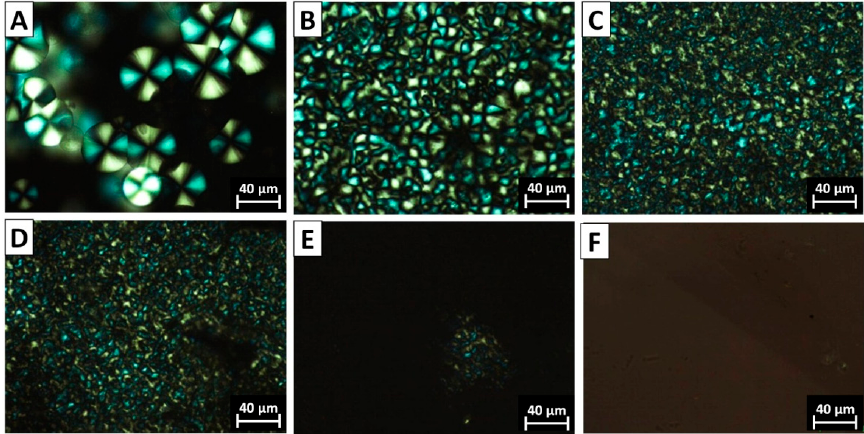
Figure 4. Polarized optical micrograph (POM) images for the PVDF@PMMA samples with the core–shell weight ratio of: ( A ) neat PVDF; ( B ) 90/10; ( C ) 80/20; ( D ) 70/30; ( E ) 60/40; and ( F ) 50/50.